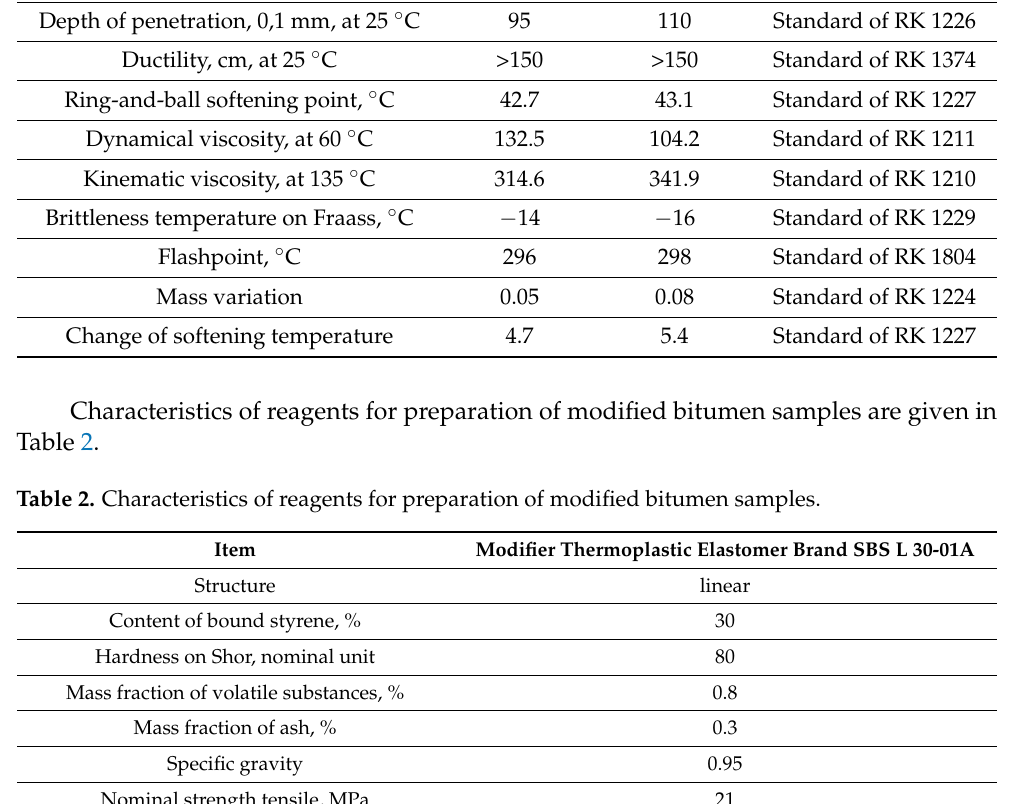
Table 1. Characteristics of raw materials for the preparation of samples of modified bitumen. Item Tar #1 Tar #2 Test Method